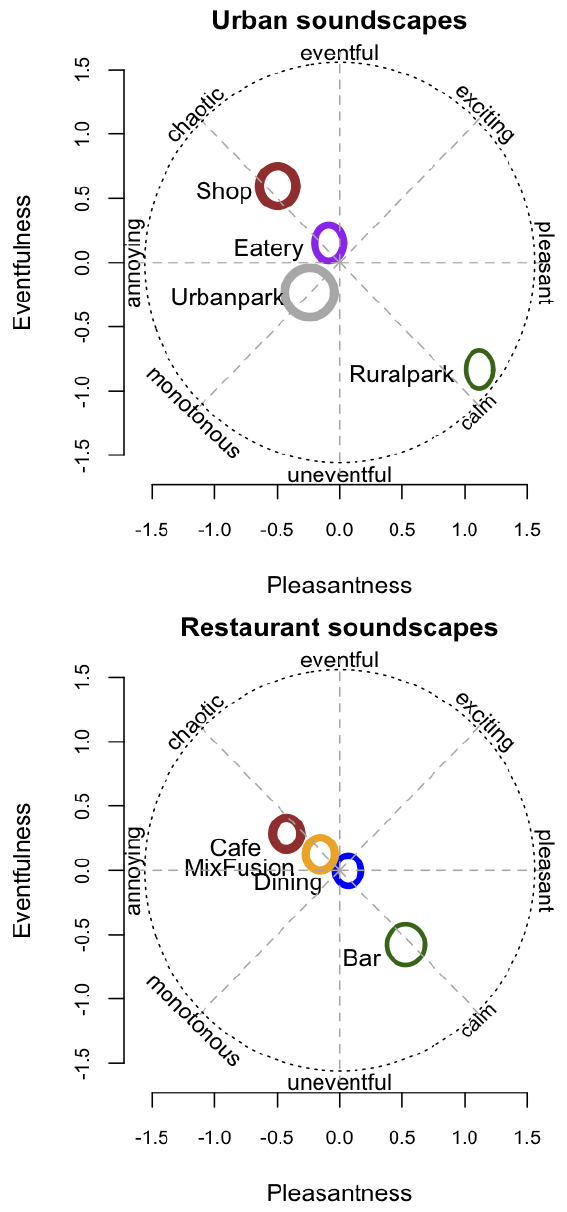
Figure 1. Perceived quality of urban and restaurant soundscape types plotted in the Pleasantness – Eventfulness circumplex. For details, see Methods section. 95% confidence ellipses are plotted, i.e., the ellipses have radii corresponding to 97.5% confidence intervals around means on x and y axes. The thickness of the ellipse circumference is proportional to the mean loudness within the type .